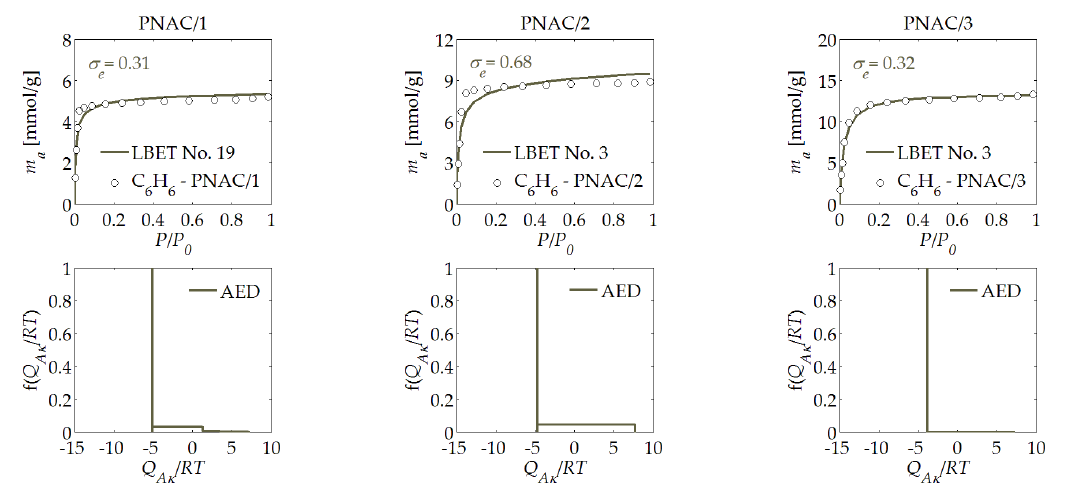
Figure 6. The same as Figure 1, but for the PNAC/ R activated carbon derived from pecan nut shells.